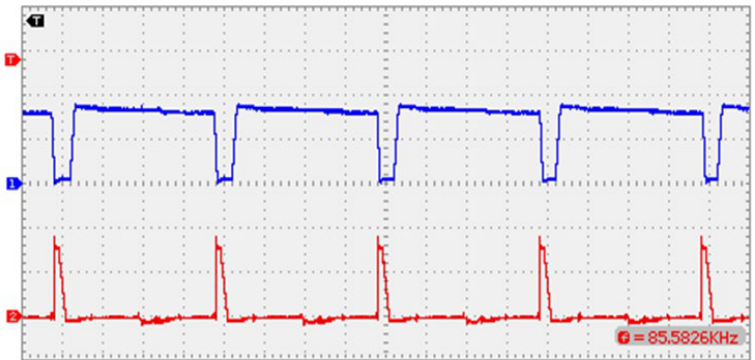
Figure 14. Voltage ( top ) and current ( bottom ) waveforms of diode D 4 (vertical scale 200 V/div or 2.5 A/div).